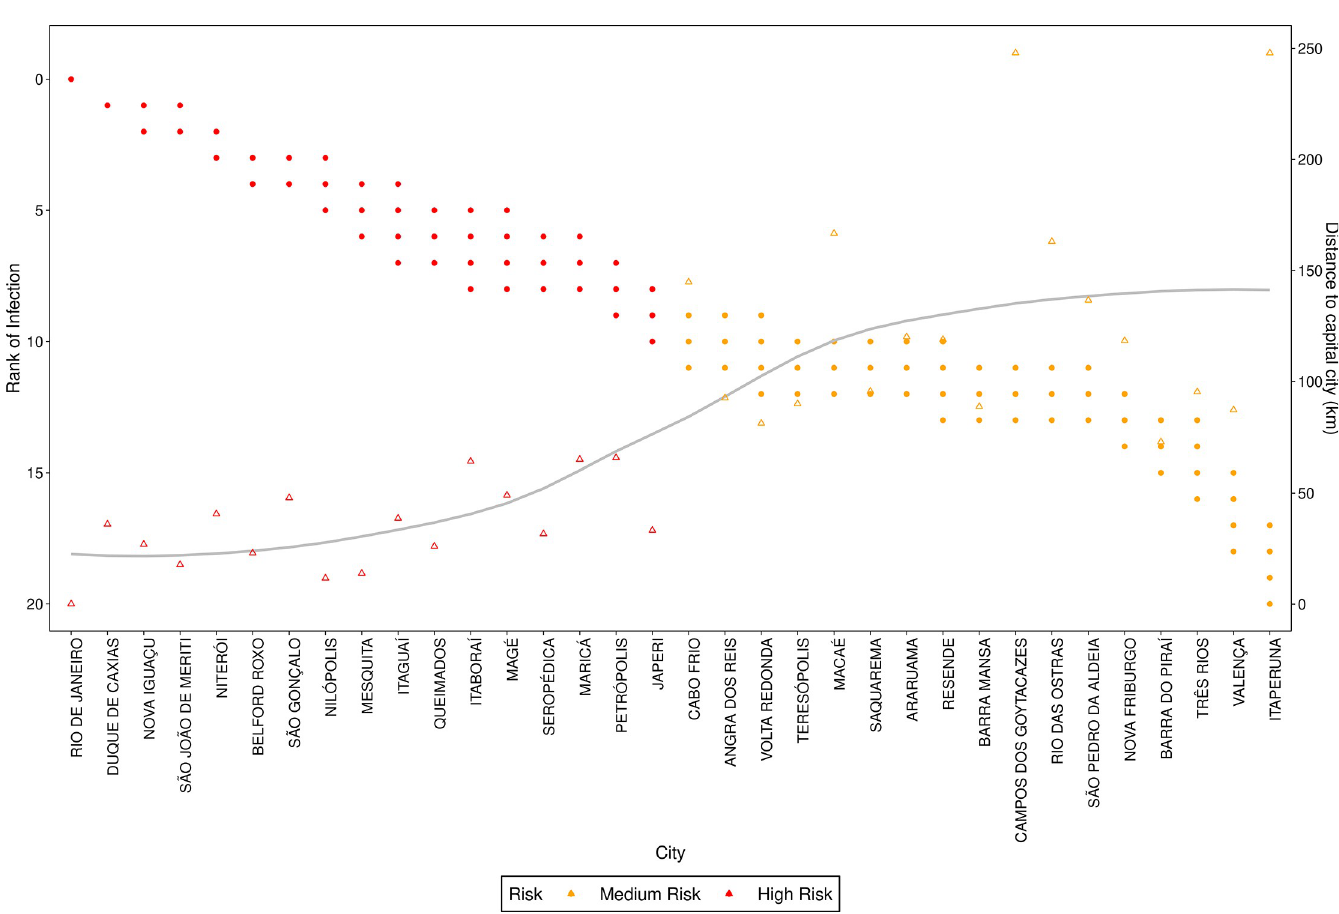
Fig 13. Rank of infection and distance to capital city for each city with more than 75,000 inhabitants in the state of Rio de Janeiro. The points refer to ranks estimated for different values of s , the triangles to the distance to the capital city and the line is a smooth approximation of the distance triangles. The colors refer to the risk evaluated by k-means clustering of the ranks attributed by the simulated